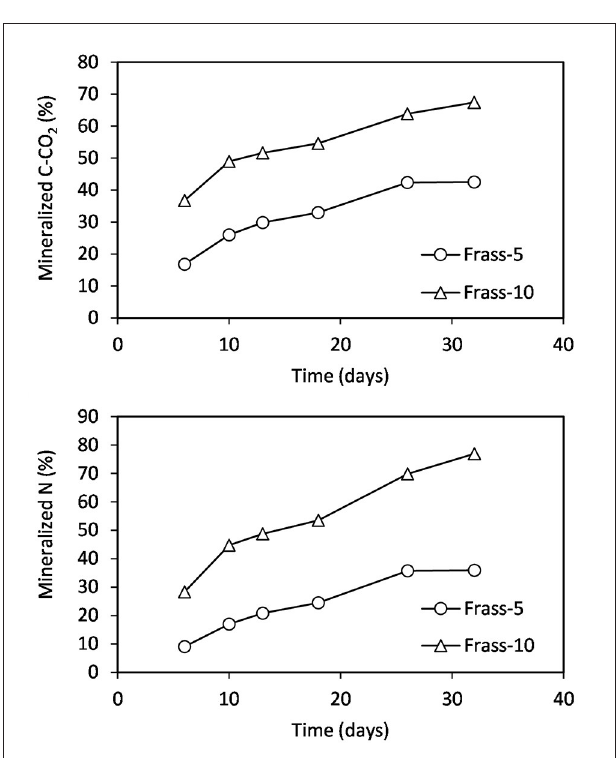
FIGURE 3 | Carbon and nitrogen mineralization of frass amended at 5t ha − 1 (Frass-5) and 10t ha − 1